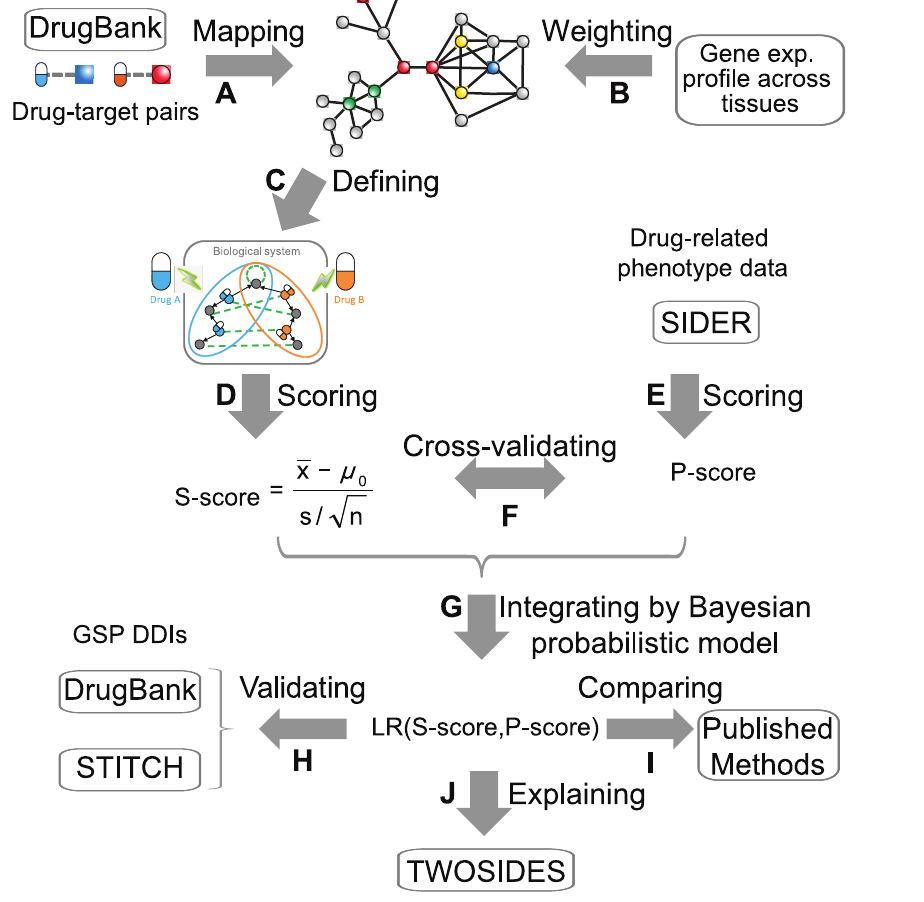
Figure 2. Algorithmic pipeline. ( A ) Mapping drugs onto PPI network through drug-target associations. ( B ) Weighting PPI network by gene expression profile across human tissues. ( C ) Defining target-centered system, including known drug-targets and their first-step neighbor protein on PPI network. ( D ) Scoring systematic connectivity based on drugs’ target-centered systems (S-score). ( E ) Scoring phenotypic similarity based on drug clinical side effects (P-score). ( F ) Cross-validating between S-score and P-score. ( G ) Integrating by a Bayesian probabilistic model. ( H ) Validating the prediction performance using GSP DDIs from two independent databases, DrugBank and STITCH. ( I ) Comparing with other methods. ( J ) Explaining the molecular mechanisms of the polypharmacy side effects recorded in TWOSIDES.